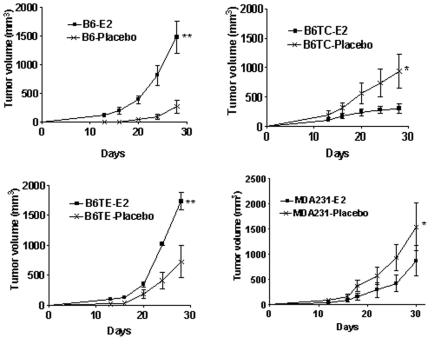
Comparison of in vivo tumorigenic property of B6TC cell with other cells.Exponentially growing tumor cells (2×106) were inoculated into both inguinal mammary fat pads of 5-week-old female athymic nude mice implanted subcutaneously with a 17β-estradiol (E2) pellet (0.72 mg/90 days) or placebo pellet. The tumor sizes were measured with a caliper in two dimensions once every week after the growth of tumors was observed. Tumor volume was the sum of two tumors in each mouse and calculated with the equation V  =  (L×W2) x 0.5, where L is length and W is width of a tumor. Values are mean ± SEM of 5 mice in each group except the B6TE-E2 group, which had 4 mice. The asterisk indicates significant difference between the growth curves with E2 or placebo pellets by a paired Student t test at P<0.05 (*) or P<0.1 (**).